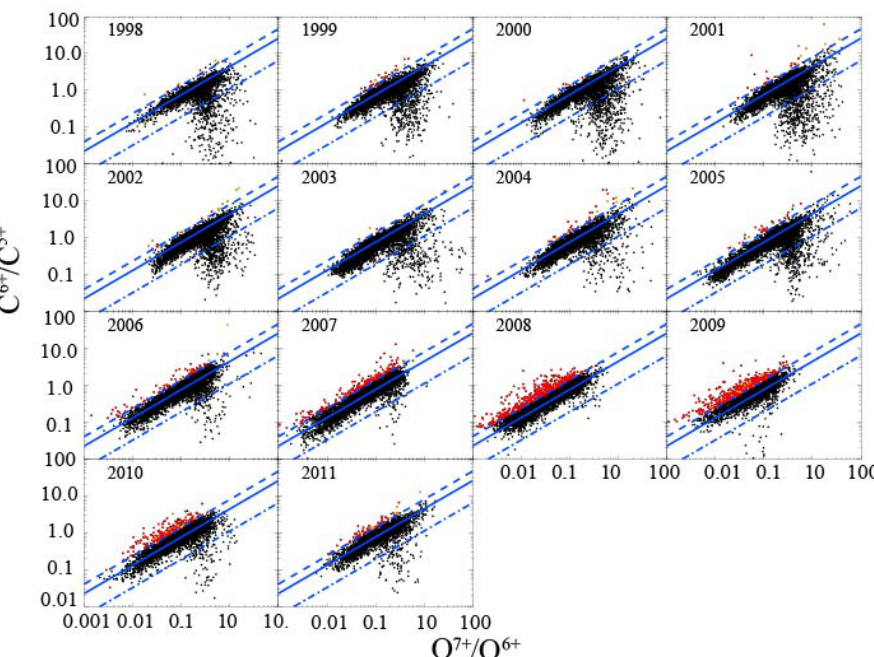
Figure 2. Annual comparison of the O 7 + /O 6 + and C 6 + /C 5 + ratios in solar wind observed by ACE/SWICS from 1998 to 2011. The linear fit of the logarithms of the O 7 + /O 6 + and C 6 + /C 5 + ratios in 2007 is shown by solid blue lines in each plot; the dashdotted blue lines are the threshold by which the Outliers are selected (see Zhao [13] for details). The dashed blue lines on the upper-boundary of these plots are one of the thresholds we use to select the UDW in this study. The slow-speed (V < 500 km s − 1 ) UDW is highlighted in